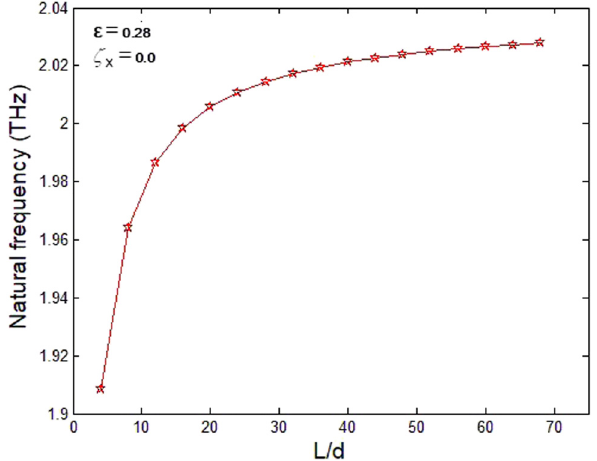
Figure 3: Variations in the natural frequency of irregular ( ε = 0.28 ) single - walled carbon nanotube against aspect ratio ( L / d ) at ( ζ = 0.0 ) .